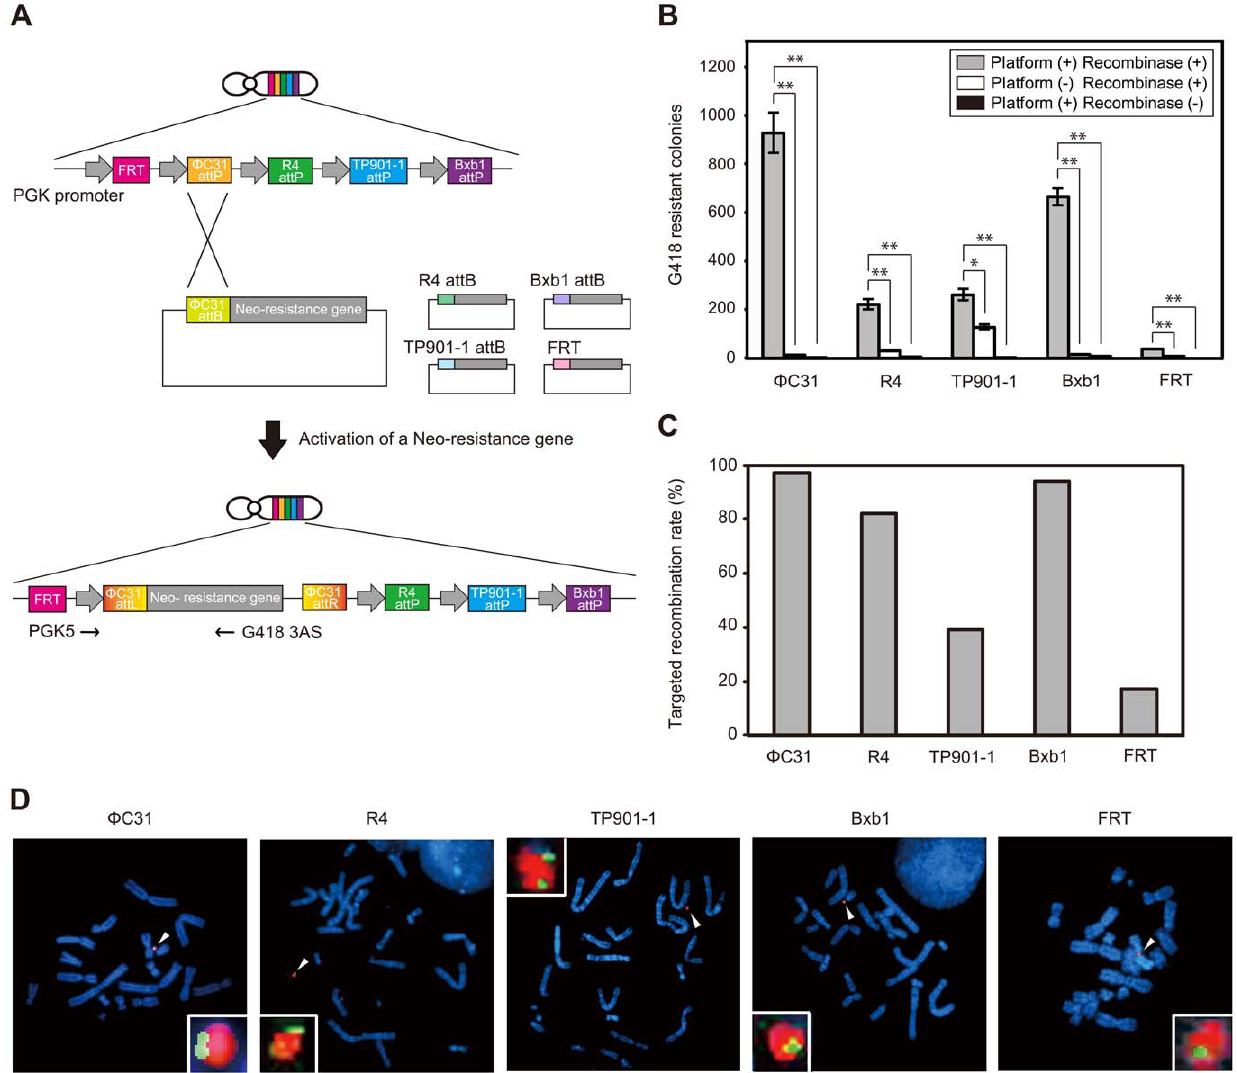
Figure 2. A direct comparison of the recombination efficiency mediated by phage integrases and FLPe. (A) Schematic diagram of the multi-integrase HAC system facilitating direct comparison of FLPe and phage integrase recombination activities. (B) In vitro integration efficiency after integrases and FLPe-mediated integration. A summary of the counted colonies for each condition after crystal violet staining is shown. Data were corrected for average colony numbers in one of the ten dishes and expressed as means 6 SE. Student’s t -test was used to determine statistically significant differences. Differences at P , 0.05 were considered significant. * P , 0.05, ** P , 0.01. (C) Site-specific recombination efficiency was determined by genomic PCR. (D) Fluorescence in situ hybridization (FISH) analysis of the recombinant multi-integrase HAC vector in CHO cells. Arrowheads indicate the dual-colored multi-integrase HAC vector during metaphase. Cells were probed with human COT-1 DNA (red) and each recombinant assay plasmid conferred fluorescence to the target cell (green).